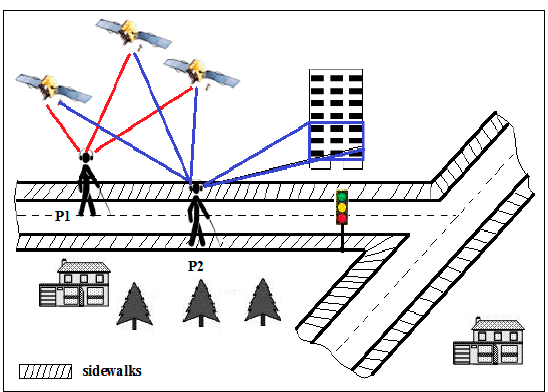
Figure 7. The result of mapping both commercial Geographical Information System ( GIS) and Global